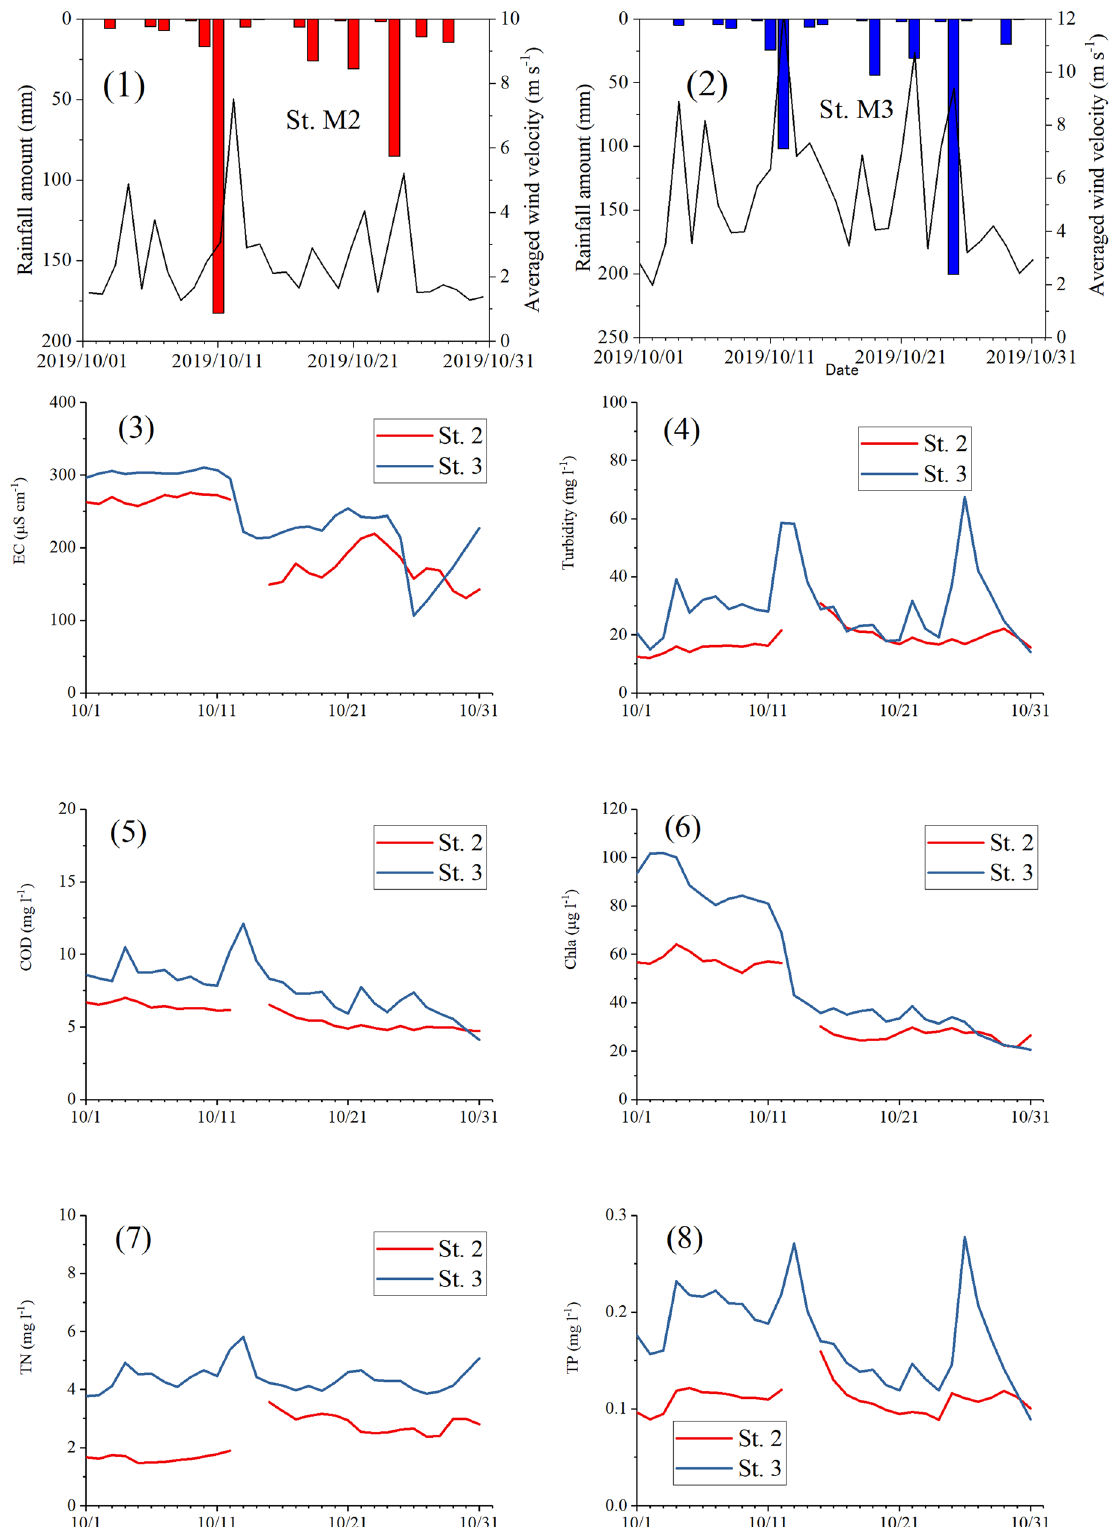
The daily precipitation and maximum wind velocity at St. M3; (3) EC, (4) turbidity, (5) COD, (6) Chla, (7) TN, and (8)